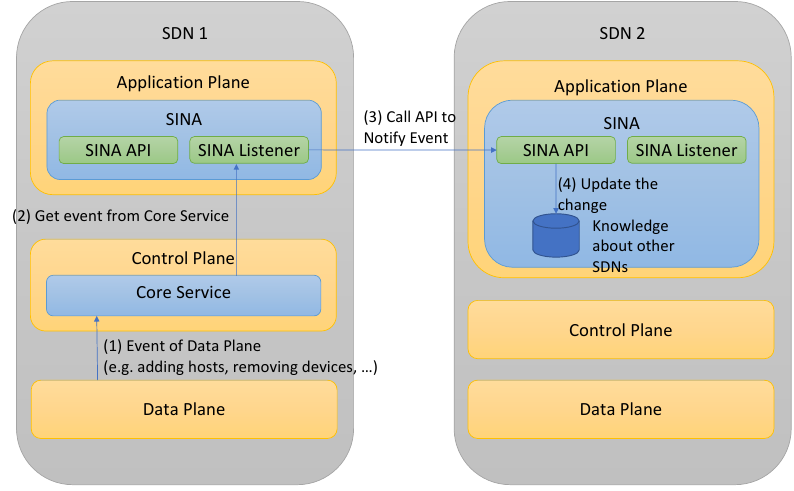
Figure 2. General architecture of SINA.